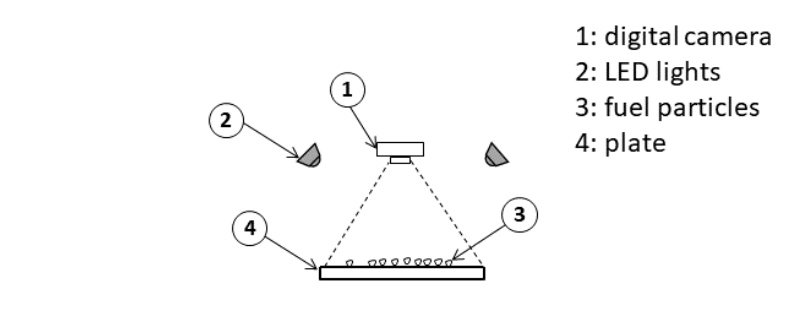
Figure 2. The setup of the particle size